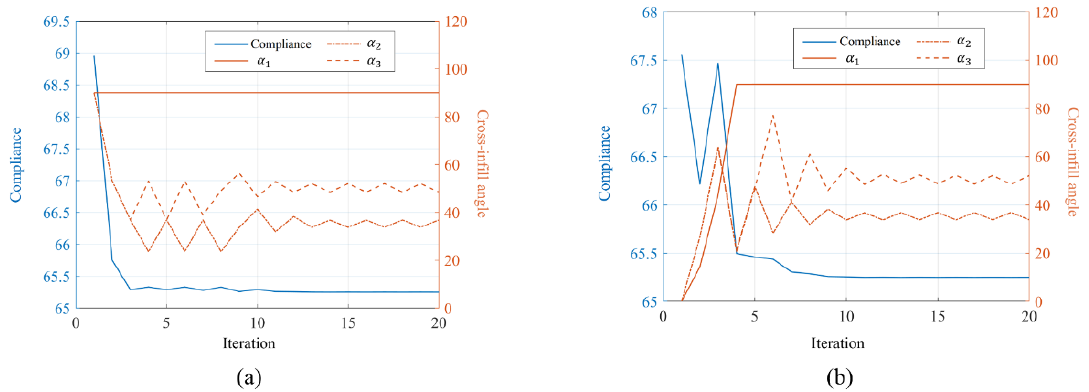
Figure 11. The convergence histories of the optimization processes from cross-infill initial guesses of ( a ) 90° – 90° and ( b ) 90° – 0°.